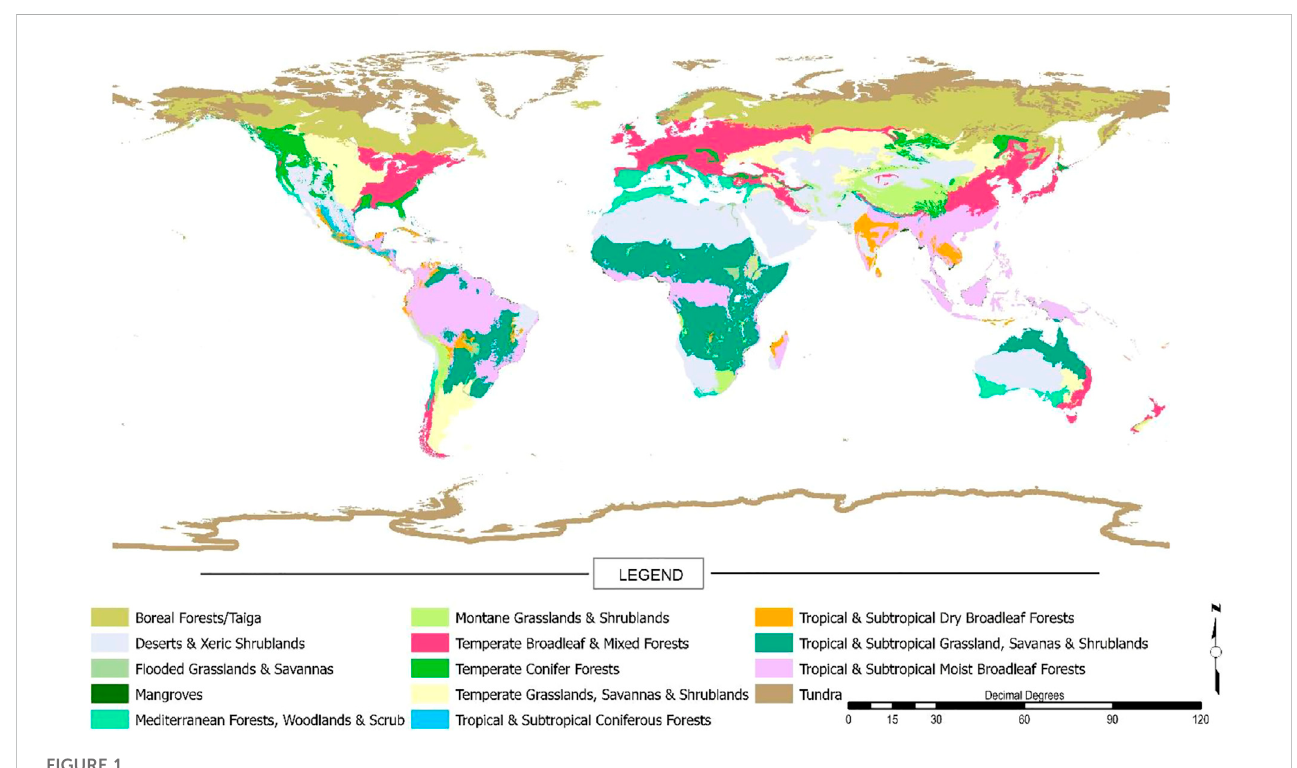
FIGURE 1 Map of the global distribution of the fourteen WWF designated biomes WWF